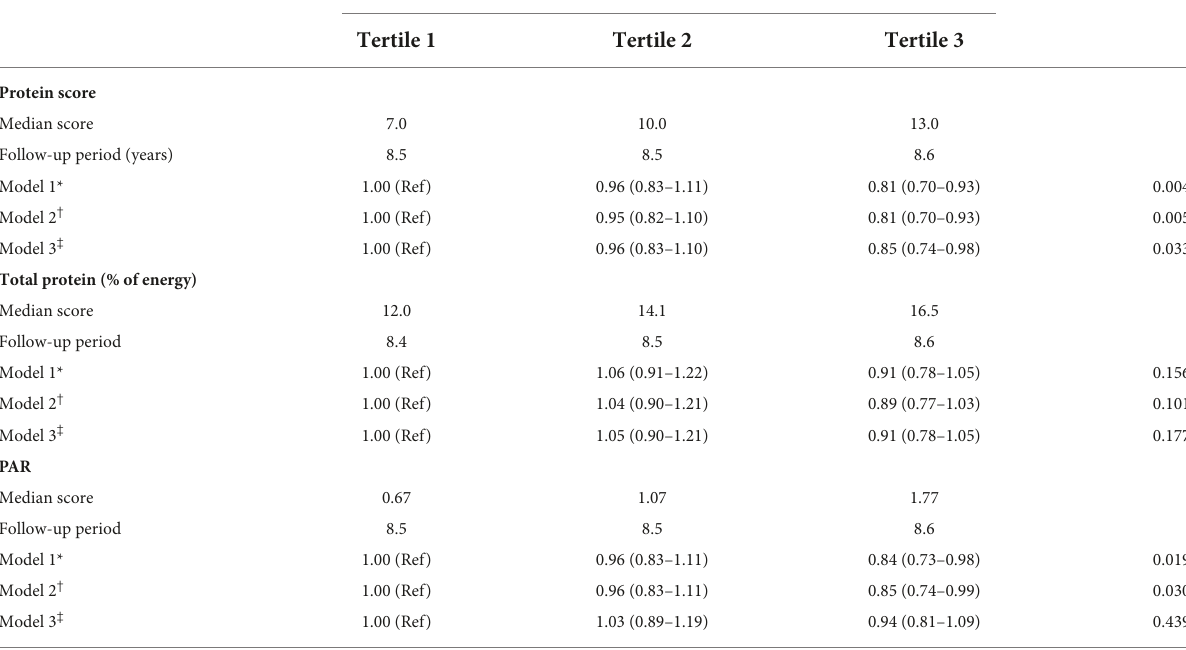
TABLE 3 Hazard ratio (95% confidence interval) of chronic kidney disease across tertile protein score and its components. Dietary indices Protein score and its components P trend *